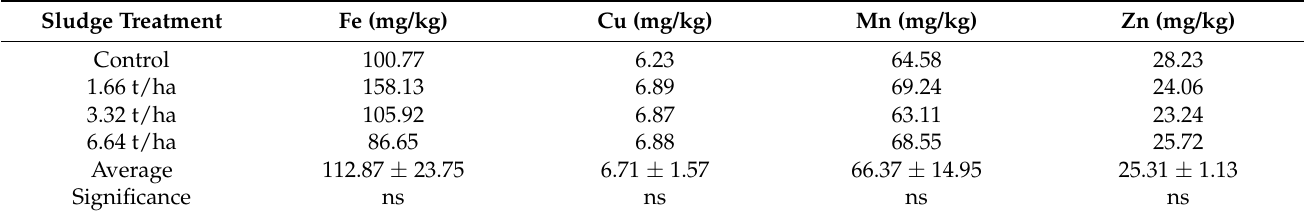
Table 8. Micro element content of Miscanthus biomass fertilized with municipal sewage